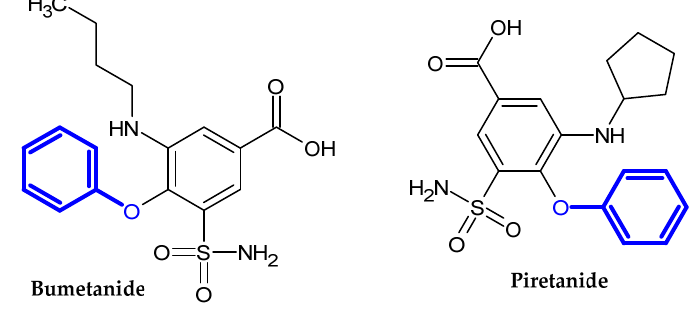
Figure 7. Anti-cholesterol drugs.